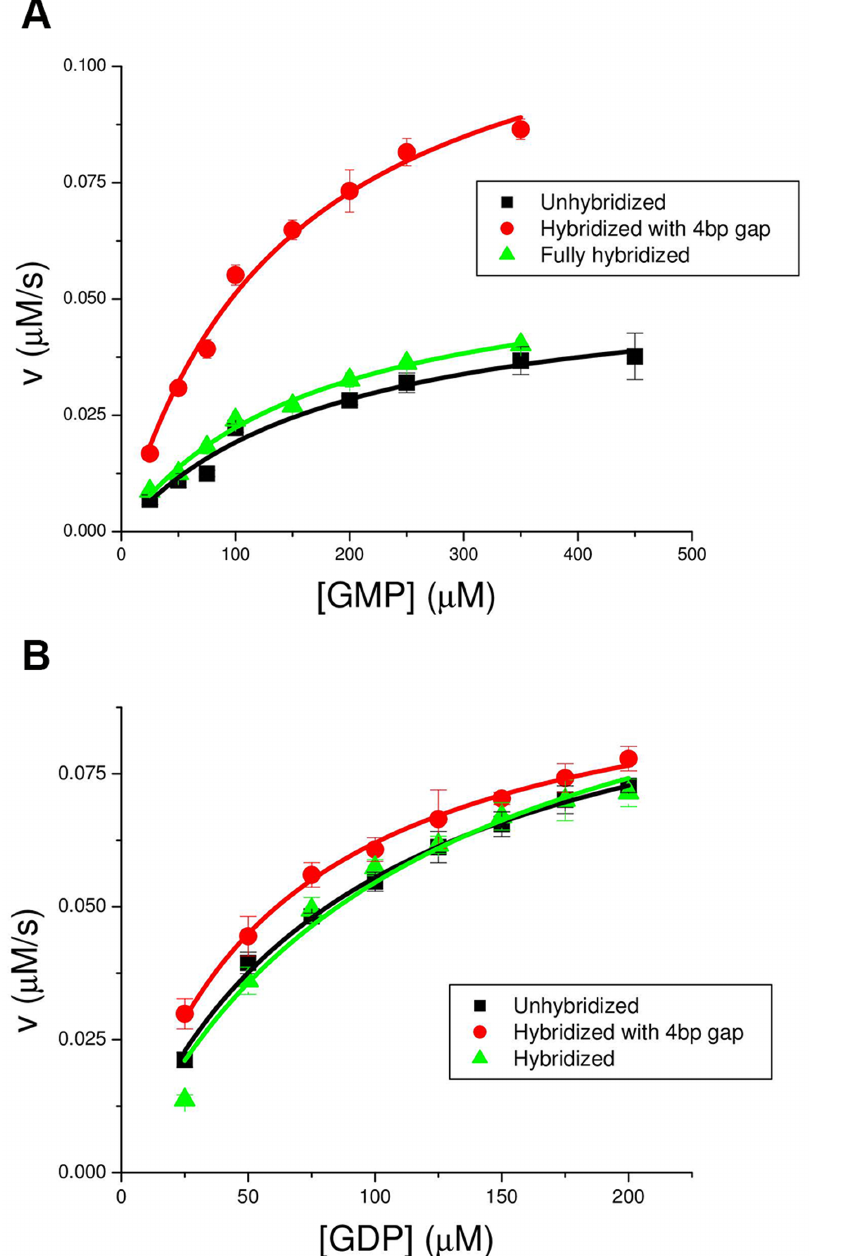
Figure 3. ‘‘Low Mg’’ titration curves (initial reaction speed vs. initial substrate concentration) for the yeast GK chimera in the absence (circles) and presence (triangles) of mechanical stress. Circles: double-stranded DNA spring with a 4 bp central gap; triangles: double-stranded DNA spring with no gap or nick. Squares: ssDNA spring; this is a confusing control explained in the text. Titrations were performed under the same ‘‘low Mg" buffer conditions ( 150 mM KCl and 5 mM MgCl 2 ) and with the same chimera sample. Here and for Fig. 4, each experimental point represents the average of 4–5 measurements (with the same chimera sample); error bars are the standard deviation. Similar titration curves were also obtained with 3 different (independent constructions of) chimera samples (data not shown), with the same result within experimental error. a) GMP titration for the forward reaction. Enzyme concentration was * 7 nM and initial ATP concentration was 400 m M. b) GDP titration for the reverse reaction. Enzyme concentration was * 20 nM (3 times larger than in (a)) and initial ADP concentration was 400 m